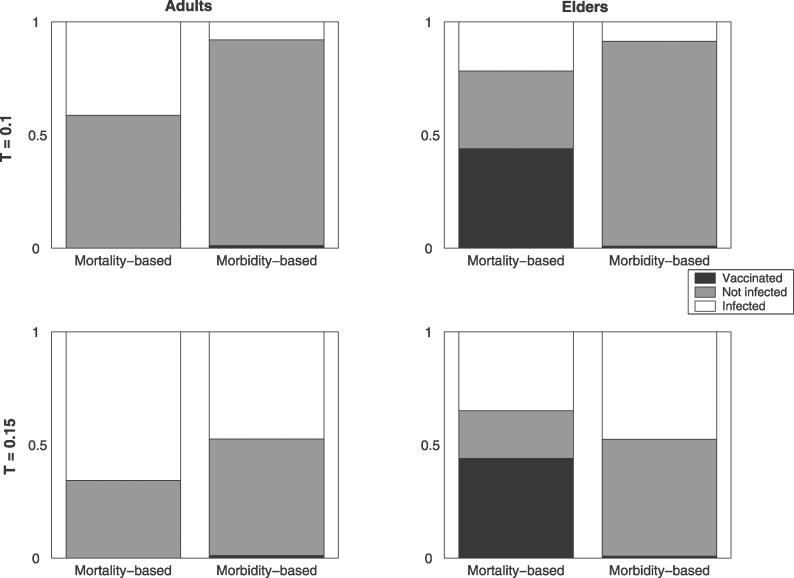
Direct versus Indirect InterventionThe figure shows the proportions of the adult and elderly populations that are infected, not infected (neither vaccinated nor infected), and vaccinated for two different values of T for the mortality-based strategy versus the morbidity-based strategy.